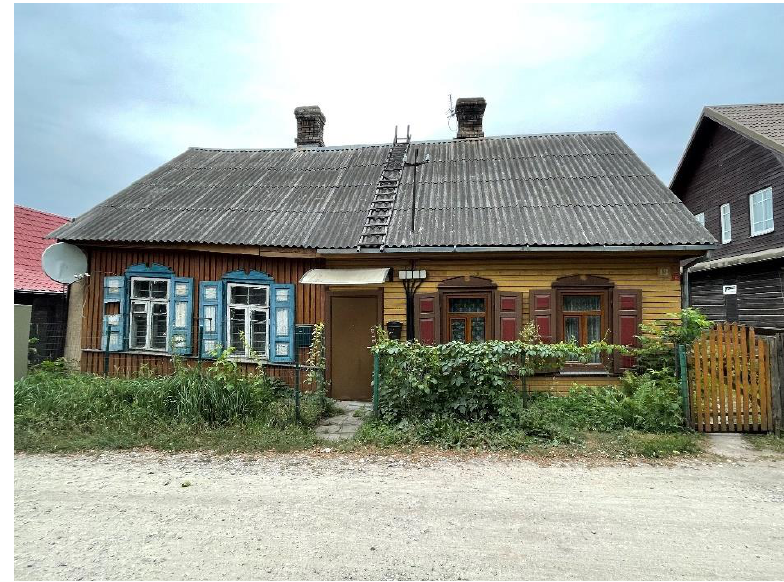
Figure 6. Wooden dwelling in Šnipiškės. Photo by A. Gabrėnienė .